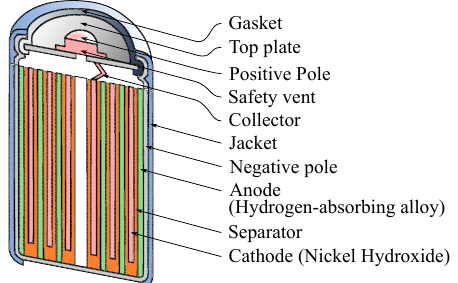
Figure 1. The structure of a Ni-MH battery